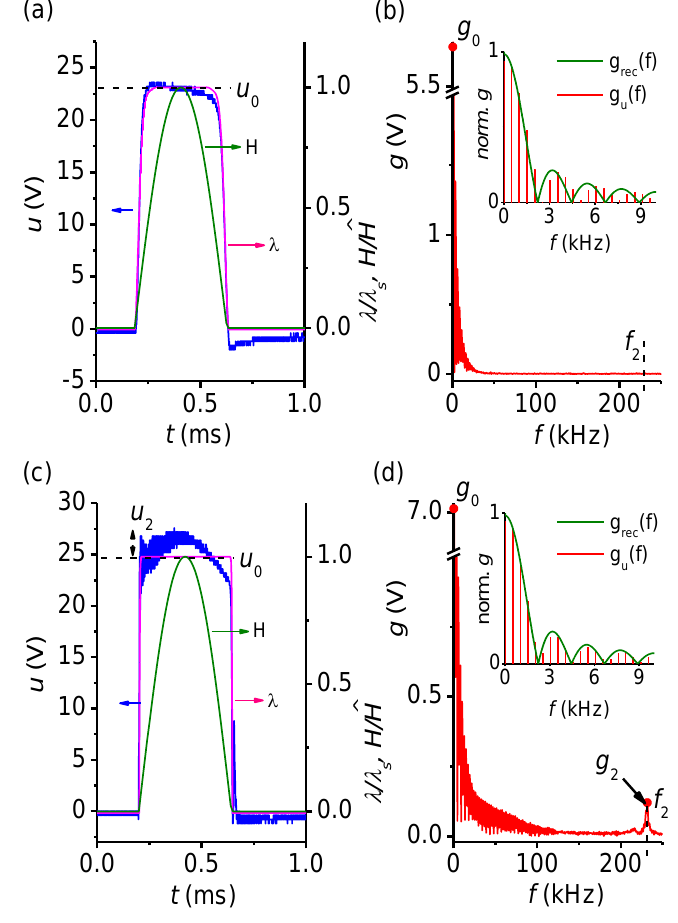
Figure 4. The time dependence u ( t ) and the frequency spectra g ( f ) of voltage pulses generated by symmetric CoFe/PZT/CoFe structure when excited by magnetic field pulses with different amplitudes Ĥ : ( a ) and ( b ) −6.5 kOe, ( c ) and ( d ) −38 kOe. The insets compare the spectrum of voltage pulse g ( f ) with that of a rectangular pulse g ( f ), with the u rec pulse length τ , with their values normalized at f = 0